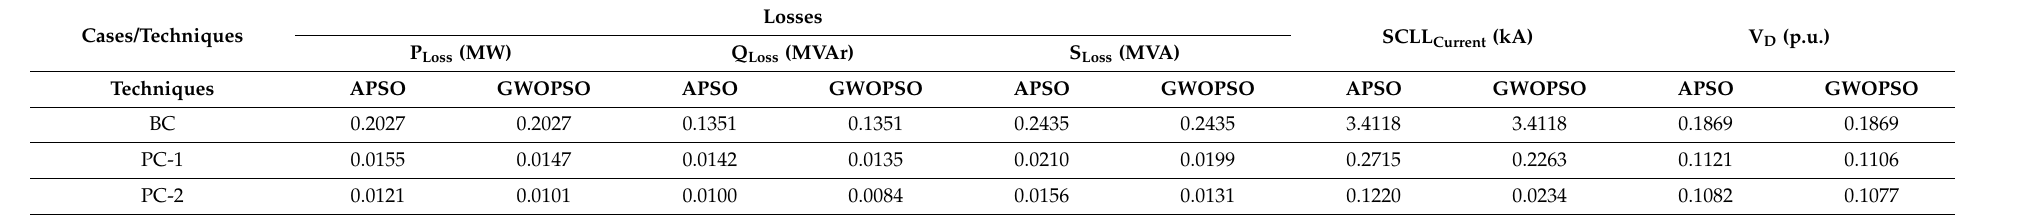
Table 6. Losses, Short Circuit Level of Line Current (SCLL Current ), Deviation in Voltage (V D ) of the 33 bus